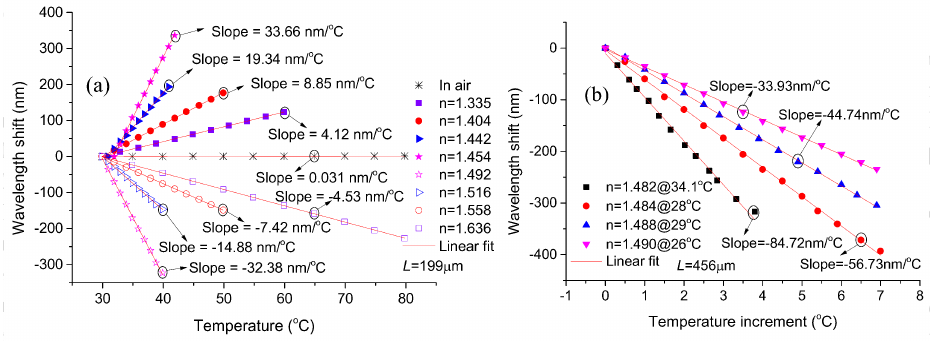
Figure 7. Spectral dip wavelength shift as functions of environmental temperature for the proposed device with cavity lengths ( a ) 199 µ m and ( b ) 456 µ m at different RIs of the filled